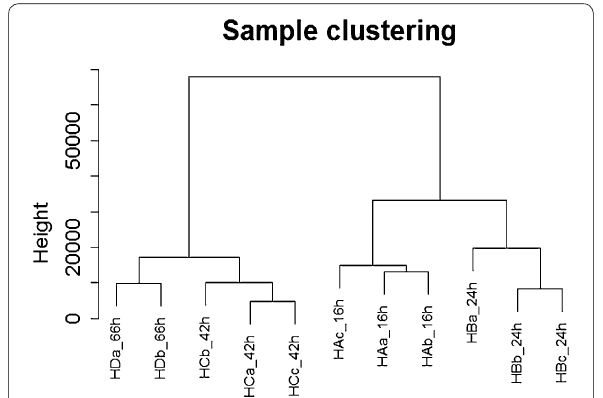
Fig. 2 Hierarchical clustering plot for all transcriptome